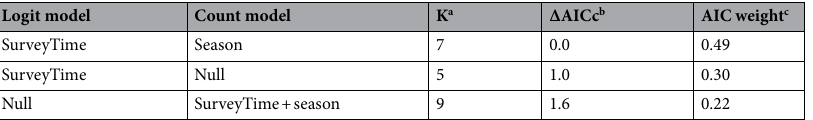
Table 1. Model selection results for analysis of diel variation in fatal bird-window collisions. Confidence set models (i.e., those with ΔAICc ≤ 2) resulting from full model selection comparison among candidate zero- inflated Poisson regression models that included factors potentially affecting numbers of fatal bird collisions found in morning, midday, and evening collision surveys in Stillwater, Oklahoma, USA in 2015–2016. Parameters in logit and count models included Season (spring, summer, fall) and SurveyTime (survey start time in decimal format). Weights are based solely on comparison of these models; full model selection results are shown in Supplementary Table S1. a Number of model parameters. b Difference in AICc value between model and top model. c AICc Weight—relative support for model.